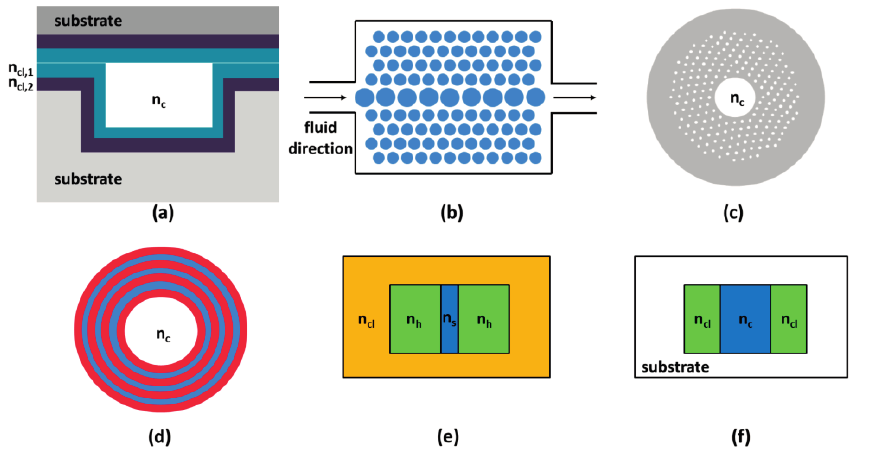
Figure 1. Schematic of some optofluidic waveguides: ( a ) ARROW waveguide; ( b ) Photonics crystal waveguide (top view); ( c ) Hollow-core photonics crystal fiber; ( d ) Hollow-core Bragg fiber; ( e ) Slot waveguide; ( f ) Liquid-liquid